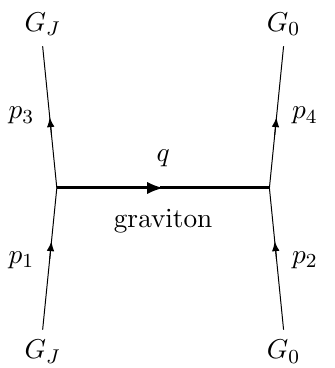
Figure 4 . Eikonal scattering of glueballs in large N gauge theory. In the limit N non-trivial contribution comes from a graviton